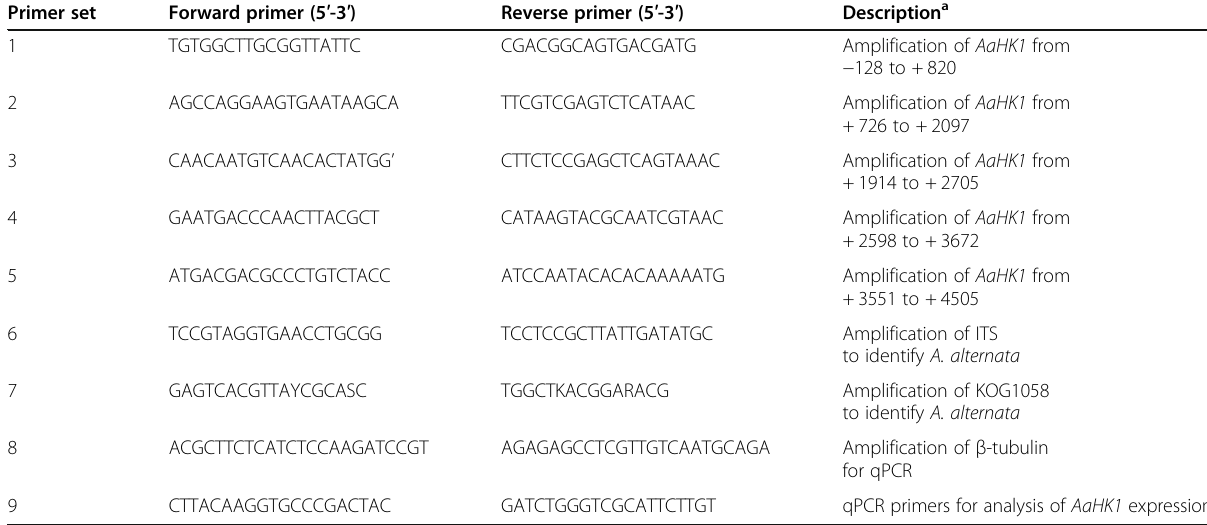
Table 6 Primers used in this study Primer set Forward primer (5 ′ -3 ′